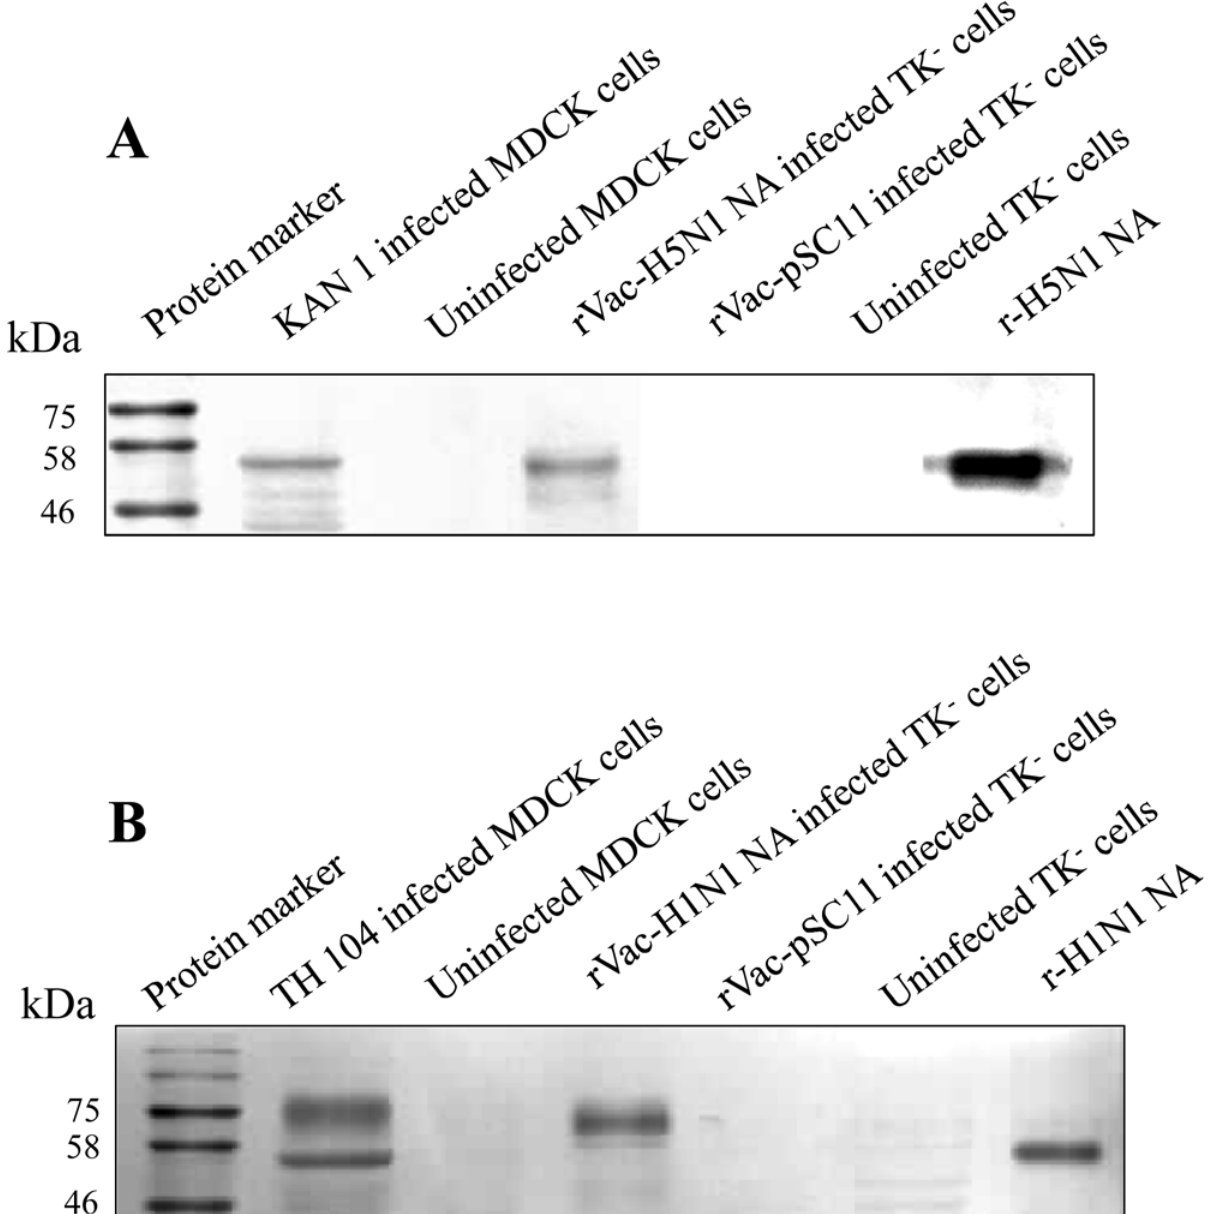
Fig 2. Molecular weights of NA proteins as demonstrated by WB assay. (A) The MW of rVac-H5N1 NA is compared with those NA synthesized in MDCK cells infected with wild type KAN-1 virus and the commercial recombinant H5N1 NA produced in mouse myeloma cells (NS0) (r-H5N1 NA). (B) The MW of rVac-H1N1 NA is compared with those NA synthesized in MDCK cells infected with wild type TH 104 virus and recombinant NA of A/California/04/2009 (H1N1) produced in insect cells (r-H1N1 NA). 104 NAs were mapped onto reference structure of A/Vietnam/1203/04 (H5N1) NA (PDB codes: 2HU0) using Chimera program (version 1.10.1) [42]. The globular head domain of NA protein starts from position 83 to 469 (N1 numbering). The amino acid positions that are the potential N -linked glycosylation sites on globular head of TH 104 NA include Asn88, Asn146, Asn235 and Asn385; and KAN-1 NA include Asn126, Asn215 (Fig 4).